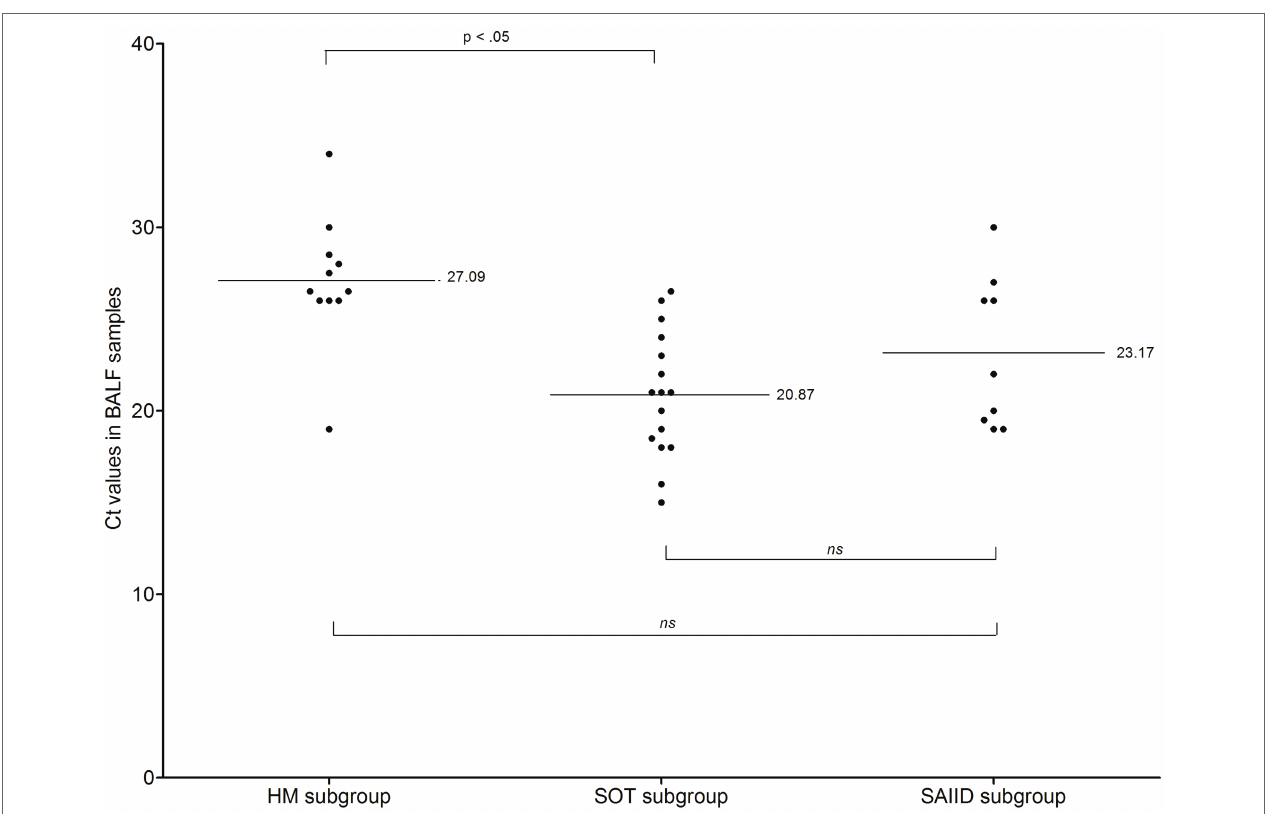
FIGURE 4 | Ct values in patients with Pneumocystis pneumonia from HM, SOT, and SAIID subgroups. Black horizontal bars, mean values. The mean value for HM patients was 27.09 ± 3.59 (range, 19–34). The mean value for SOT patients was 20.87 ± 3.42 (range, 15–26.5). The mean value for SAIID patients was 23.17 ± 4.14 (range, 19.5–30). Mean Ct value was significantly lower in SOT patients than in HM patients (Bonferroni’s test, p < 0.05). No significant difference was observed between SOT patients and SAIID patients or between HM patients and SAIID patients. BALF, Bronchoalveolar lavage fluid; Ct, cycle threshold; HM, hematological malignancy; ns, non-significant; SAIID, systemic autoimmune and inflammatory disorder; and SOT, solid organ